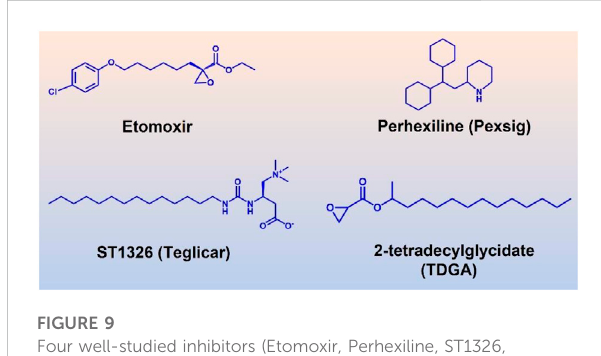
FIGURE 9 Four well-studied inhibitors (Etomoxir, Perhexiline, ST1326, TDGA) of